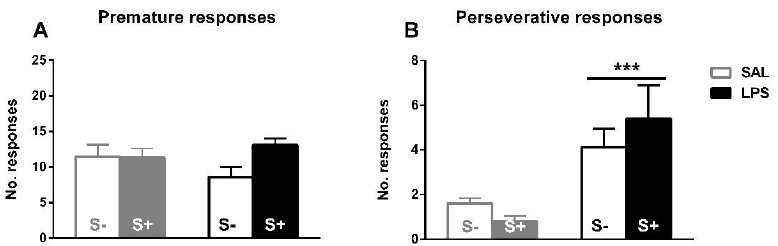
Figure 5. 5-CSRT task inhibitory control variables in saline-control (SAL/S-), LPS-control (LPS/S-), Scheme 12. ( A ) Baseline mean premature errors. ( B ) Baseline mean perseverative errors: asterisks represent that animals exposed to LPS (LPS/S- and LPS/S+) had a significantly more perseverative behavior than controls ( p < 0.001). Data is represented as mean ± SEM.